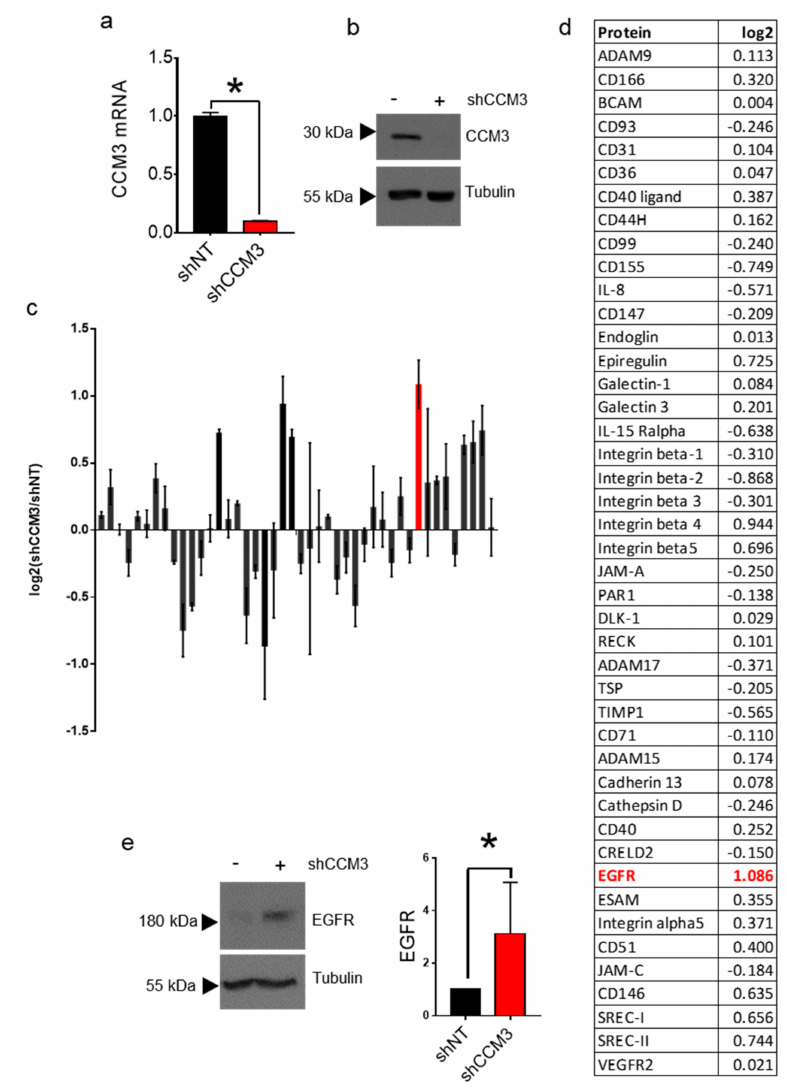
Figure 1. Analysis of membrane proteins in CCM3-deficient human umbilical vein endothelial cells (HUVECs); ( a ) CCM3 mRNA levels in HuVECs transduced with shNT and shCCM3 shRNAs. * p < 0.001; ( b ) CCM3 protein levels in the same cells; ( c ) Di ff erences levels of membrane proteins between shNT and shCCM3 HuVECs as seen in a proteome profiler array; ( d ) List of proteins in the proteome profiler assay, with the log2 of their di ff erence between shCCM3 and shNT cells. EGFR shown in red. ( e ) Western blot of Epidermal Growth Factor Receptor (EGFR) HuVECs transduced with shNT and shCCM3 shRNAs. Right panel: quantification of EGFR Western blots. * p <